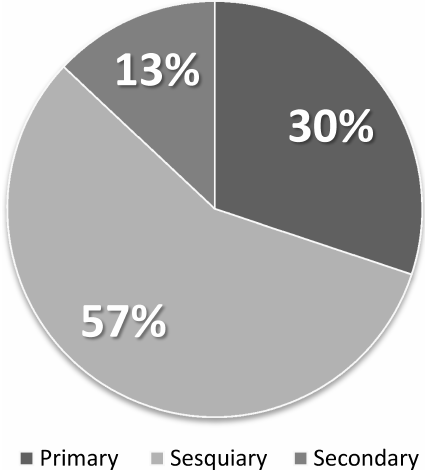
Figure 6. A breakdown of re-classification of the Lower House election tweets according to the redefined